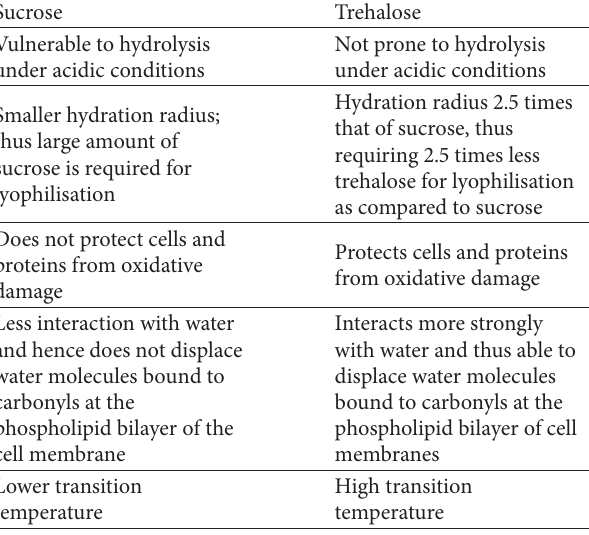
Table 1: Advantages of trehalose over sucrose as a